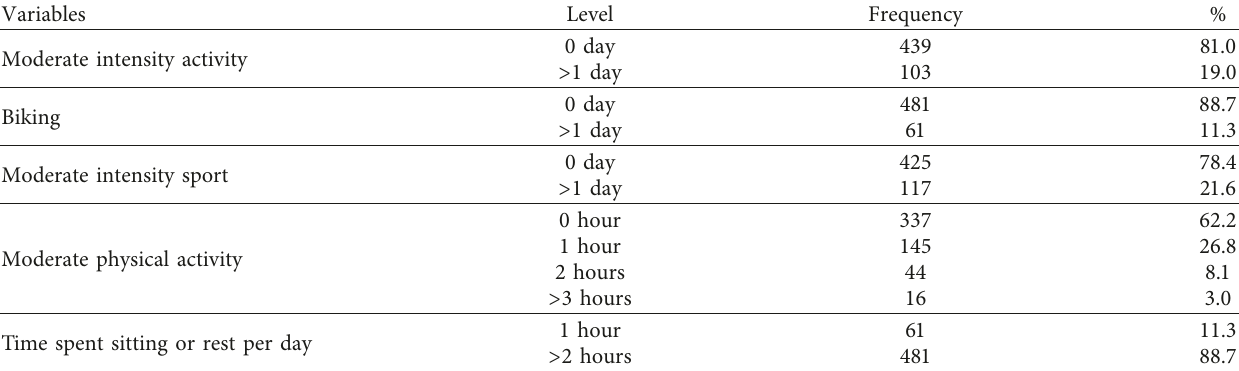
Table 3: Physical activities among women of reproductive age in Dire Dawa, 2021 ( n � 542).